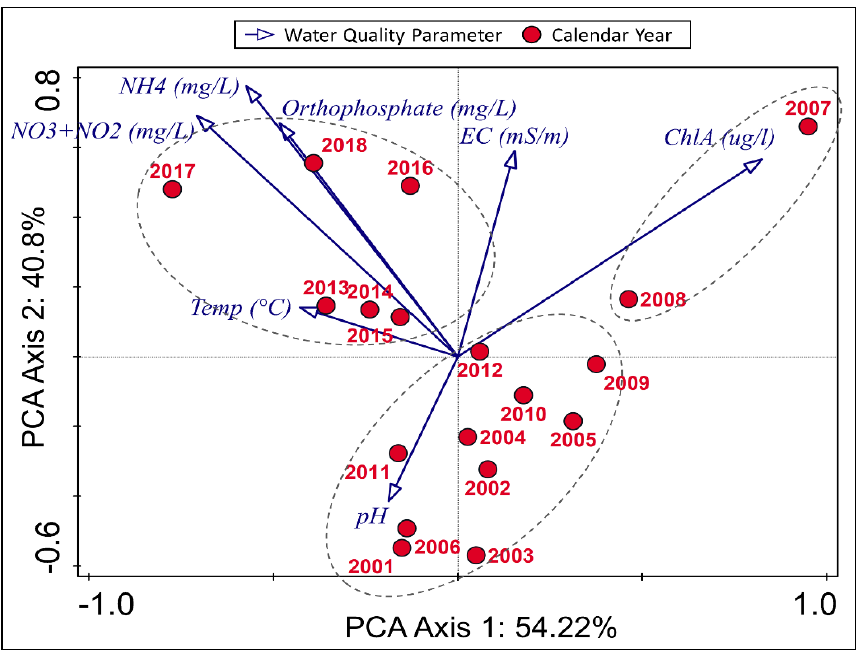
Figure 4. Principal Component Analysis (PCA) biplot indicating variation in selected water quality variables in Roodeplaat Dam from 2001 to 2018. Individual data points are mean values representing four sampling locations (A, B, C, and D) for each calendar year.